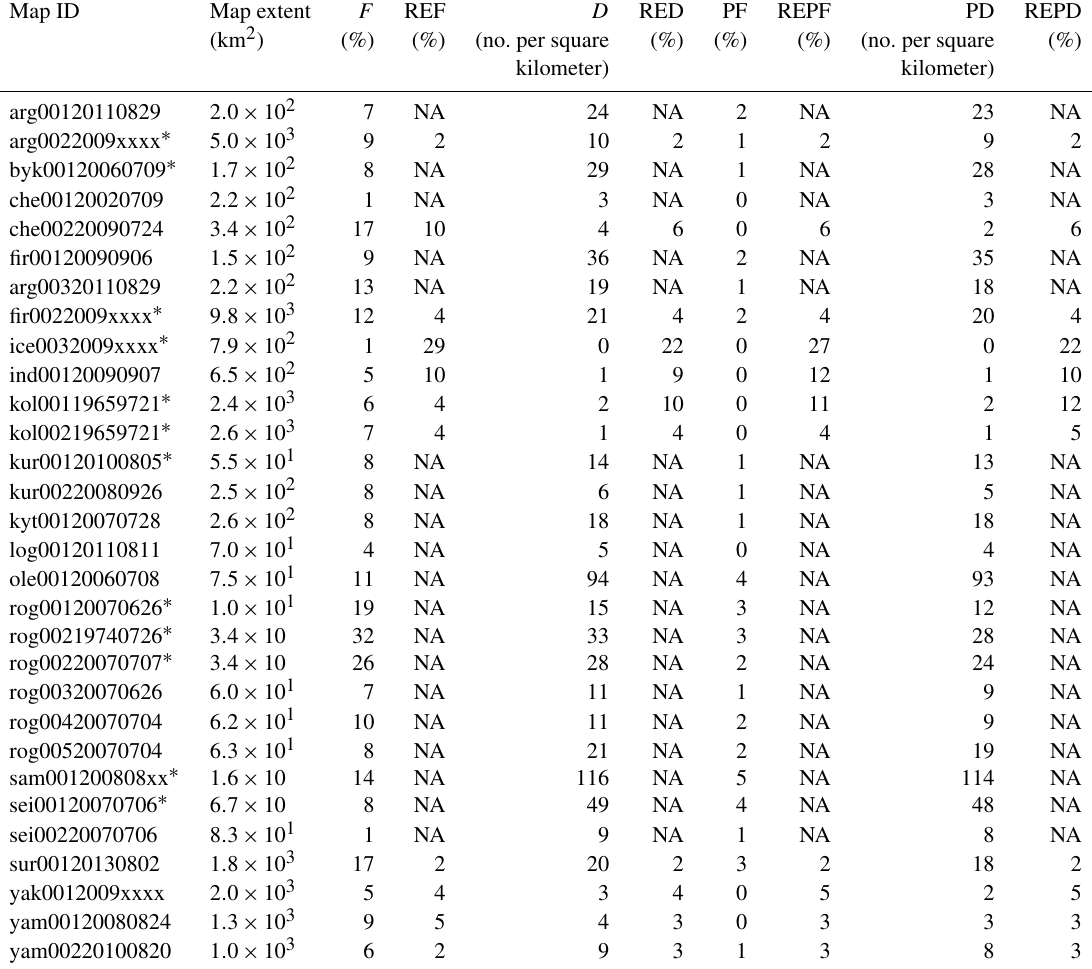
Table E4. Areal fraction and density per waterbody map in Russia. Map IDs with an asterisk were not used for extrapolation. F : areal fraction of waterbodies from 1 . 0 × 10 2 to 1 . 0 × 10 6 m 2 in size; REF: relative error of fraction for map subsets of 10km × 10km; D : waterbody density per square kilometer; RED: relative error of density; PF: pond areal fraction for waterbodies from 1 . 0 × 10 2 m to smaller than 1 . 0 × 10 4 m 2